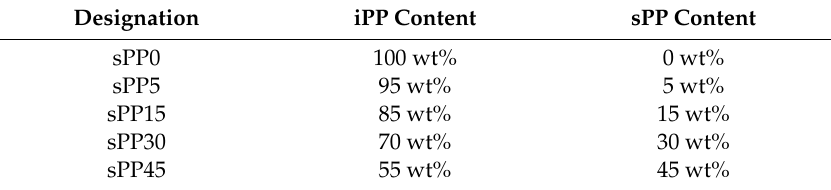
Table 1. Catalogue of polypropylene (PP) blend samples investigated in this work.